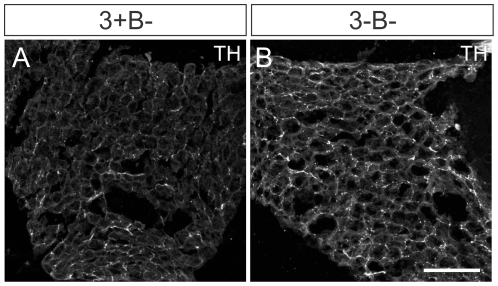
Normal sympathetic innervation was observed in some tissues in the absence of Egr3 and neuron death.In brown fat for example, which receives dense sympathetic innervation to regulate thermogenesis no definitive changes were observed in (A) 3+B− relative to (B) 3-B− mice. (scale bar  = 100 µm).